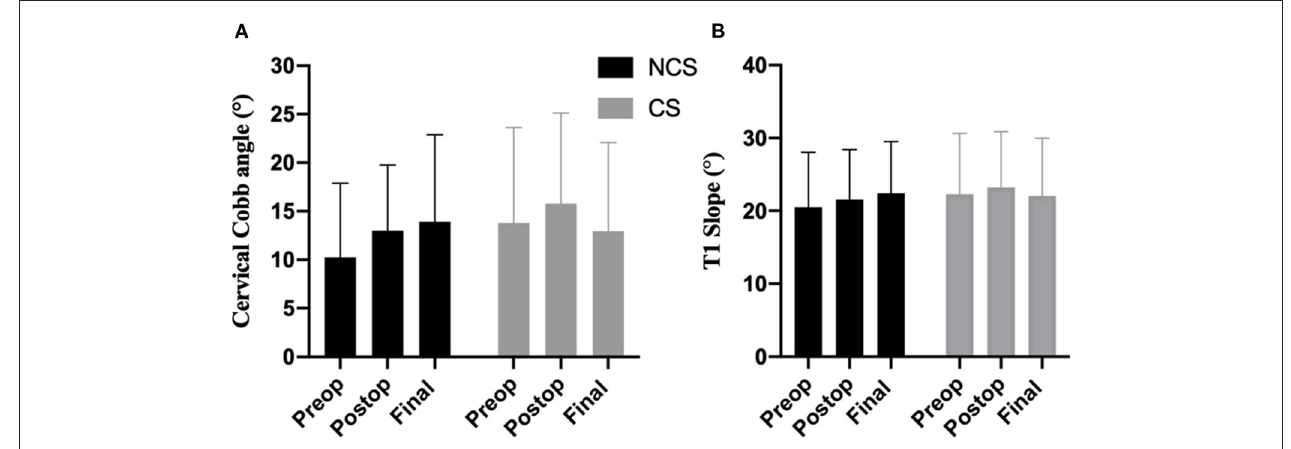
FIGURE 2 | The mean cervical Cobb angle (A) and T1 slope (B) values in CS (cage subsidence) and NCS (non-cage subsidence)